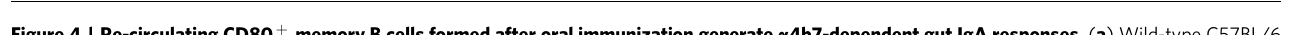
Figure 4 | Re-circulating CD80 þ memory B cells formed after oral immunization generate a 4b7-dependent gut IgA responses. ( a ) Wild-type C57BL/6 mice were orally primed with three doses of 20 m g NP-CTat 10 days apart and 6–12 months later CD80 þ and CD80 (cid:2) B cells from the Spl, MLN or PP were sorted using a FACSAria and injected intravenously into m MTrecipient mice that had been orally immunized once with 10 m g of CT 10 days earlier. One day after cell transfer m MT mice were orally immunized with 20 m g NP-CT and the anti-NP and anti-CT responses in serum or SI LP (AFC) were monitored. ( b ) Depicts the frequency of responding mice based on detection of anti-NP (left) or anti-CT (right) IgA or IgG serum antibody responses (as depicted in c ) after transfer of CD80 þ or CD80 (cid:2) B cells using 1 (cid:3) 10 5 cells from MLN and PP and 2–10 (cid:3) 10 5 from the spleen (Spl). The number of recipient mice in each group ( n ¼ ) is given in the left panel for NP responses. ( c ) Specific log 10 antibody titres in individual mice that responded to an oral challenge immunization (ND, not detectable). ( d ) Small intestinal LP anti-NP or anti-CT IgA responses given as AFCs/10 6 cells in m MTmice injected with CD80 þ memory B cells from indicated tissues. The data presented in a – d are based on the data pooled from four independent experiments giving similar results. ( e ) Mice adoptively transferred with NP-specific GFP-expressing B cells were orally or i.p. primed with NP-CTand 6 months later a challenge dose with NP-CTwas given orally or i.p. ( f – i ) The percentage of GFP þ CD138 þ /all plasma cells in the SI LP and spleen of responding mice ( f ) and GFP þ B220 þ /all B cells in the PP and spleen in these mice ( g ). ( h ) A statistical analysis of the impact of p.o. versus i.p. priming or p.o. versus i.p. challenge immunizations for strong IgA responses (explained in Supplementary Fig. 6b,c). ( i ) Tissue sections of the PP and spleen showing GC location of responding of GFP þ memory B cells after challenge. ( j ) Orally primed mice were treated with a 4 b 7-blocking DATK32 Mab before and during p.o. or i.p. challenge immunizations with NP-CT and the number of GFP þ plasma cells in SI LP sections were determined (explained in Supplementary Fig. 6a). The Mann–Whitney nonparametric test was used for statistical analysis of GFP þ gut homing plasma cells in the presence or absence of a 4 b 7 Mab blockade ( P ¼ 0.0120). Results in e – j are based on the pooled data from three independent